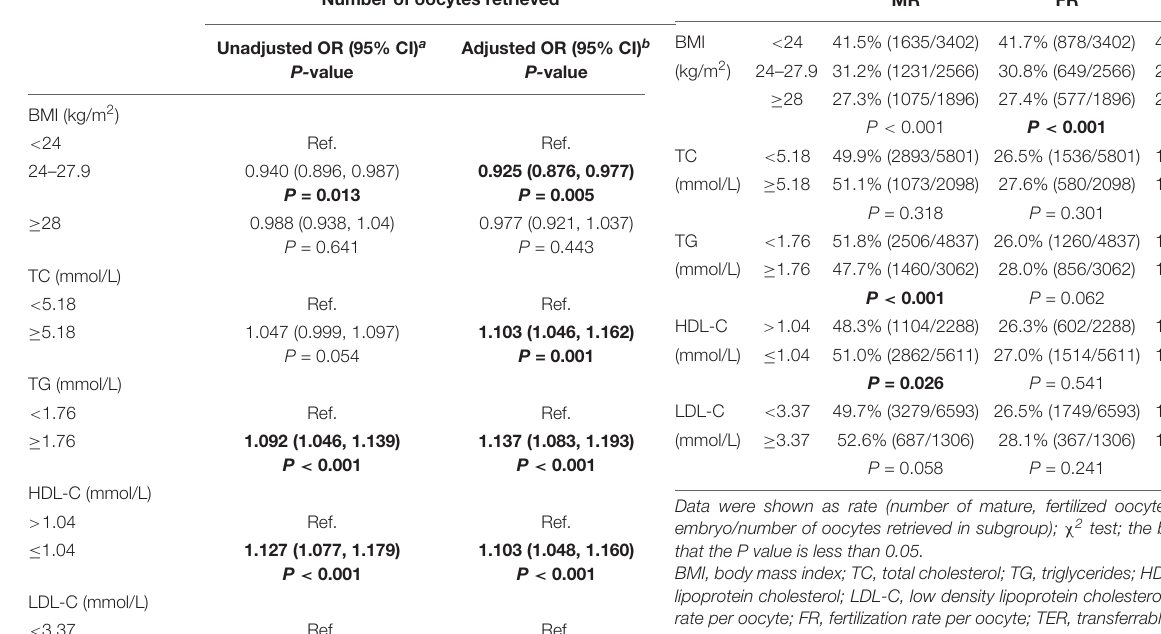
TABLE 3 | Oocyte maturation quality and developmental potential by BMI, TC, TG, HDL-C, and LDL-C groups.